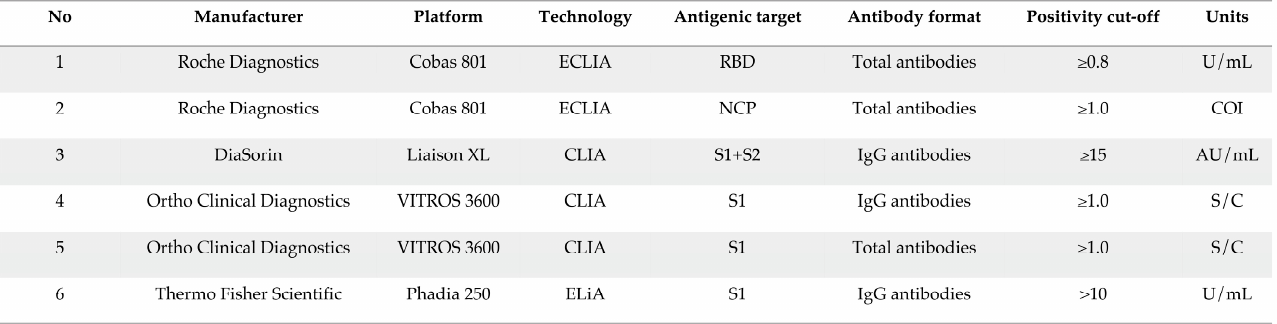
Table 1. Characteristics of the six assays used in this study.